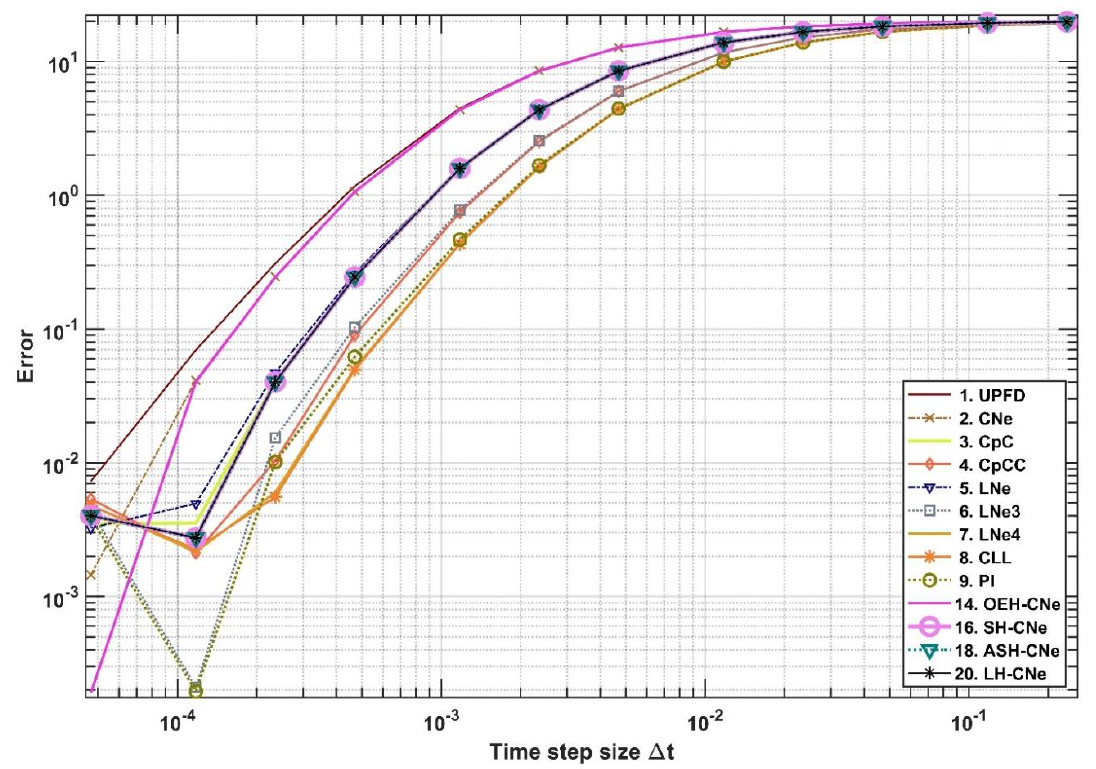
Figure 11. The maximum errors as a function of the time step size ∆ t for the slowly converging methods in the case of Experiment 5.